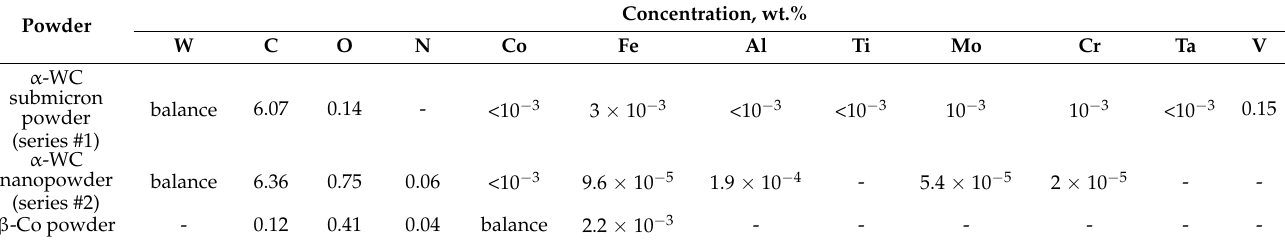
Table 1. Chemical composition of initial WC and Co